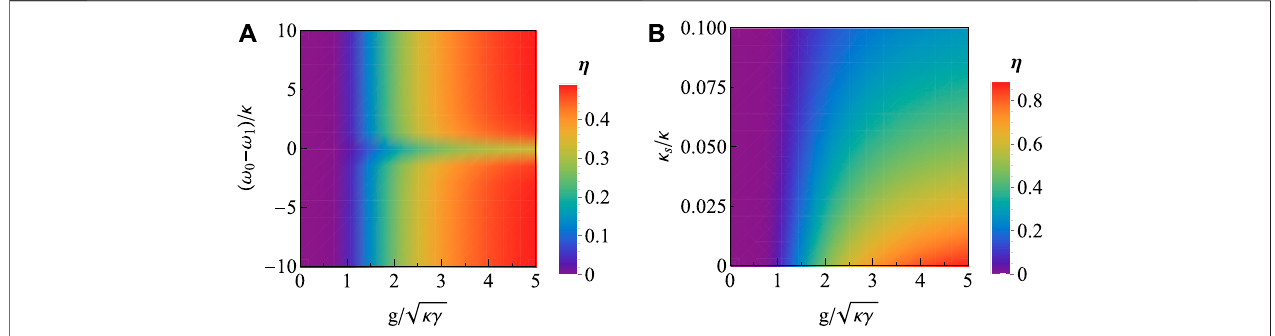
(cid:8)(cid:8) √ κγ and ( ω 0 − ω 1 )/ κ with ω 0 = ω c and κ s / κ = 0.05. (B) The ef fi ciency of high- fi delity